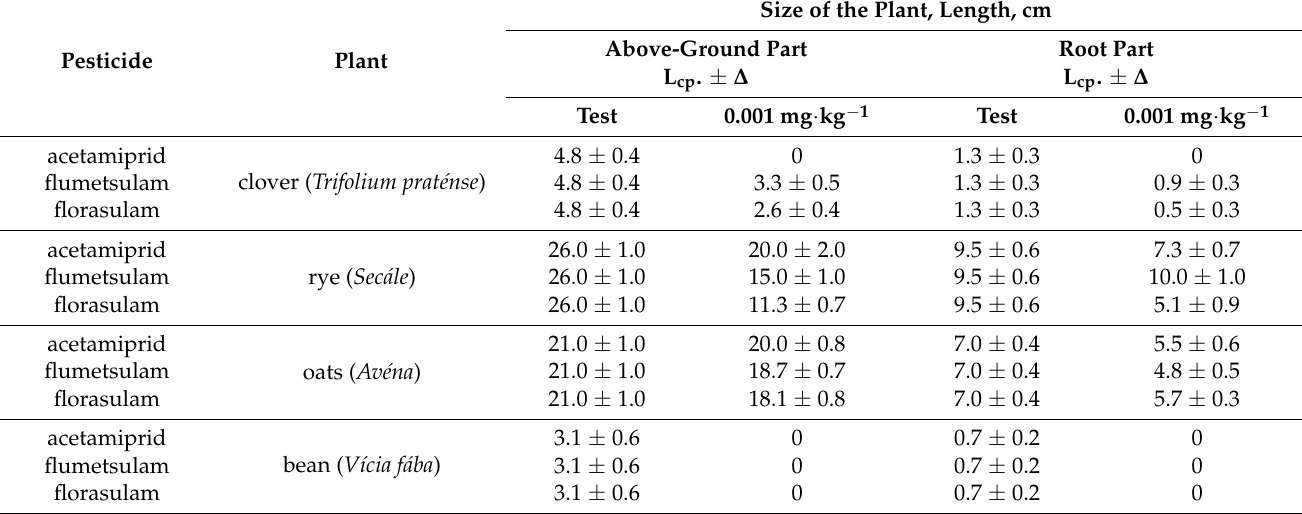
Table 4. Changes in the morphological parameters for agricultural crops: rye, oats, bean and clover upon the application of pesticides ( n = 15, p =